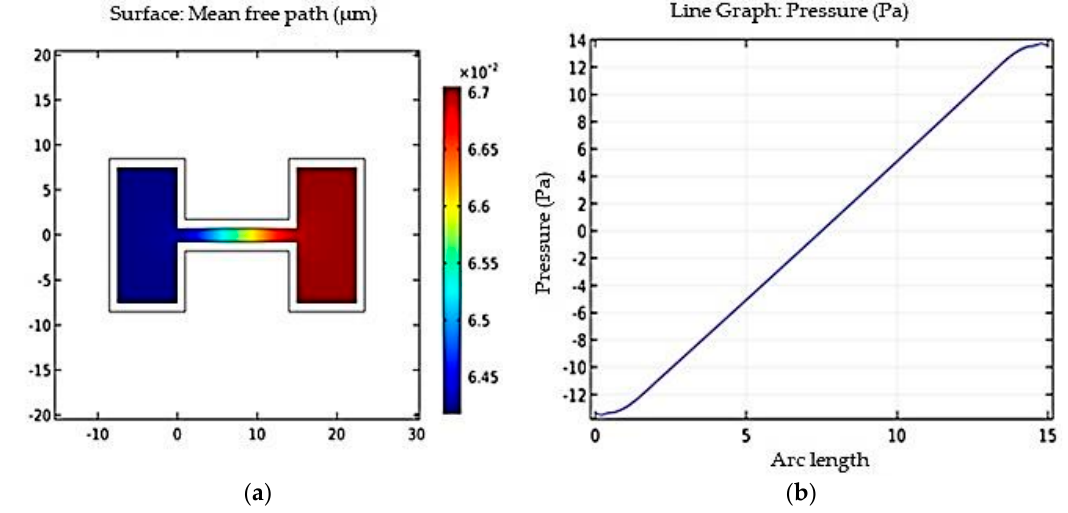
Figure 4. ( a ) Mean free path vs. channel length; and ( b ) pressure along channel length vs. arc length.